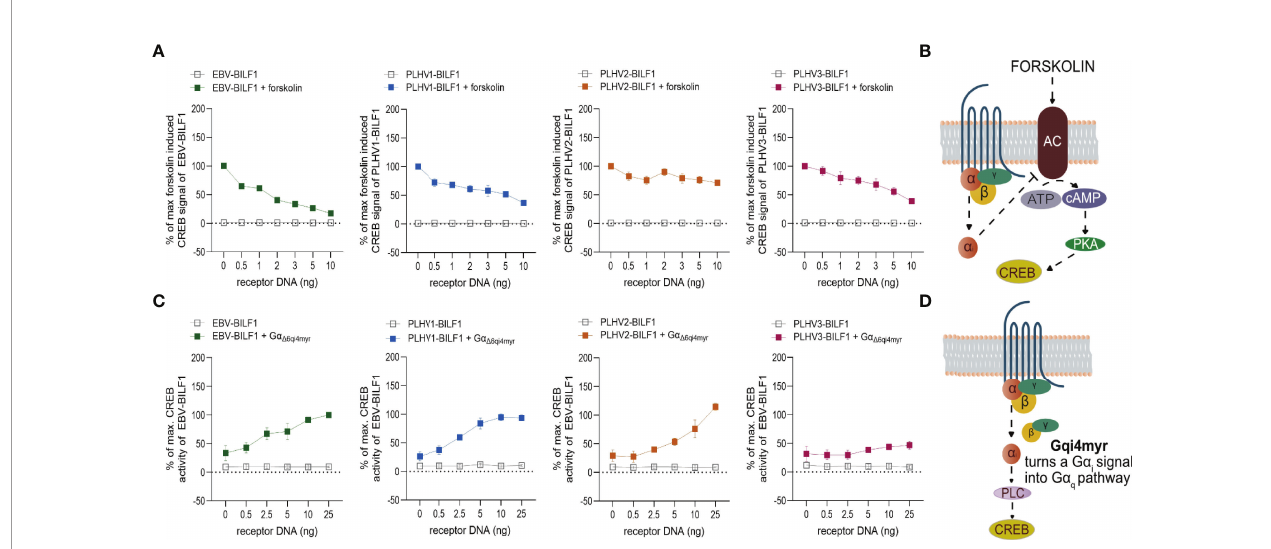
FIGURE 2 | BILF1 receptor signaling is G a i dependent. (A) HEK-293A or (C) HEK-293 cells were transiently co-transfected with different concentrations of BILF1 orthologues 30ng/well of CRE cis-reporter plasmid. (A) HEK-293A cells were stimulated with 10µM of forskolin for 5 hours, before gene-dose dependant CRE activity of BILF1 receptors was measured. (C) HEK-293 cells were additionally co-transfected with 30ng/well of G a D 6qi4myr and CRE activity was measured 24 hours after transfection (values are means ± SEM; n = 3). (B) Forskolin induces cyclic AMP formation and enables the observation of its decrease mediated by receptors. (D) Chimeric G protein G a D 6qi4myr is recognized by receptor as a G a i , but functions as a G a q subunit, resulting in increased activity of phospholipase C (PLC) and hence CRE